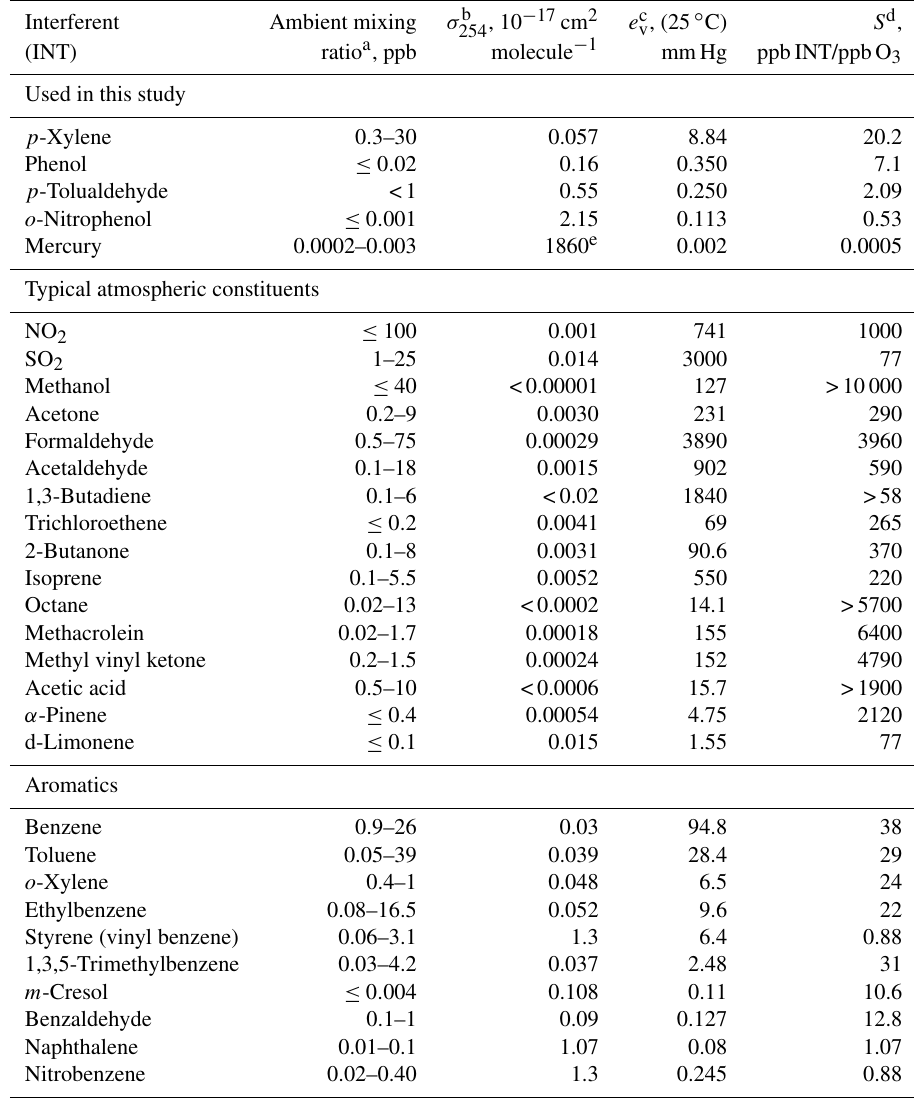
Table 1. Properties of VOCs and other atmospheric species that are potential interferents in UV-absorption-based ozone measurements. Interferent Ambient